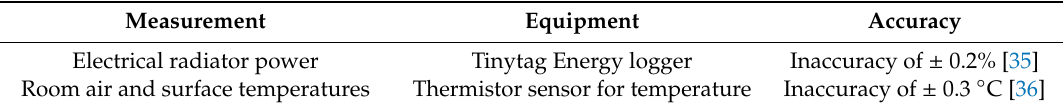
Table 2. Measurement equipment and accuracy.